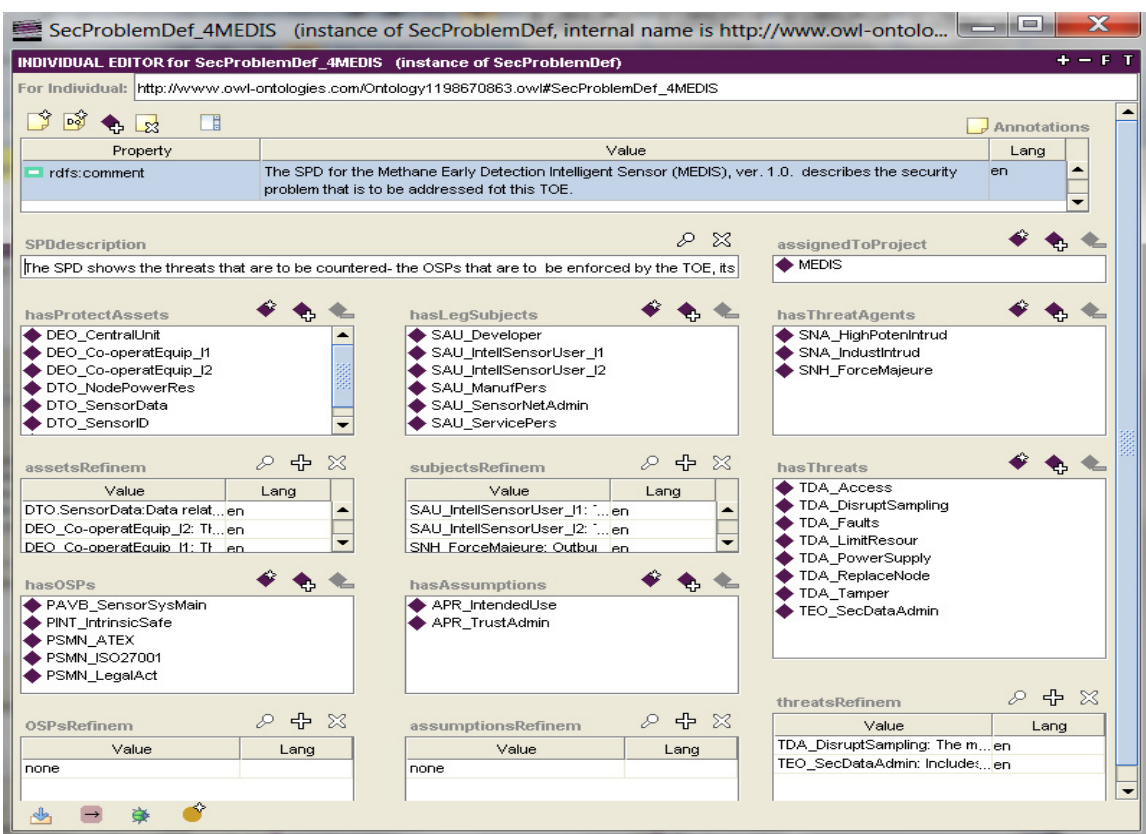
Figure 3. The MEDIS security problem definition in the Protégé tool [5].